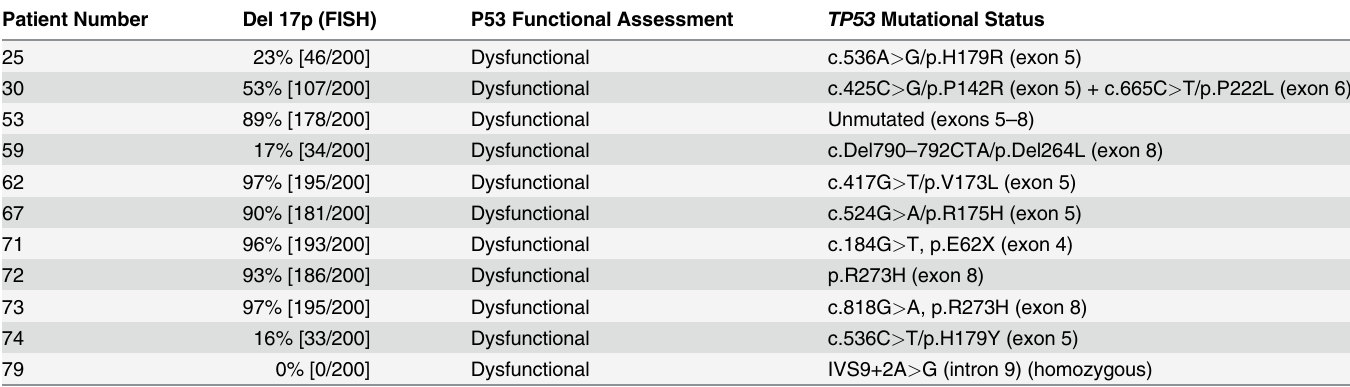
Table 3. CLL patients with TP53 abnormalities.